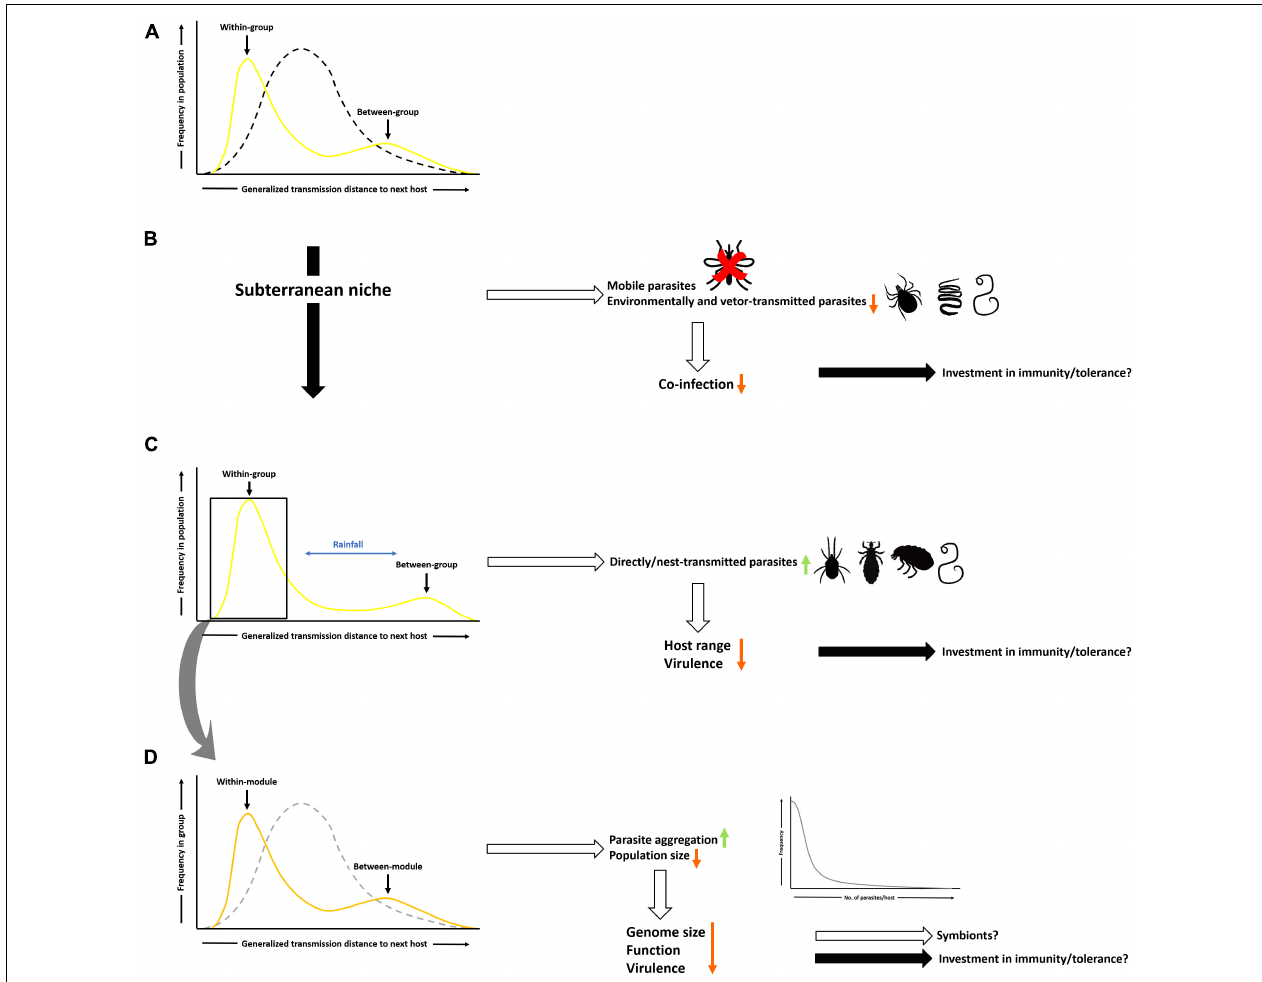
FIGURE 2 | Compositive distance space [i.e., generalized transmission distance (GTD) derived from spatiotemporal, genetic and ecological distance between hosts, a theoretical measure of transmission distance] and its predicted effects on parasite exposure and selection pressures on parasites and bathyergid hosts. This measure incorporates characteristics of the social organization and group size of a particular species. (A) GTD is unimodal for solitary hosts (black, dashed line) but bimodal for social hosts (yellow line) due to short GTDs between group members (within-group) but long GTDs between groups. (B) Living in a subterranean environment excludes mobile parasites and reduces exposure to environmentally-transmitted or vector-borne parasites (e.g., ticks, helminths). For parasites (open arrows) this reduces their degree of co-infection with variable host investment (solid arrows) in physiological defenses (i.e., resistance vs. tolerance). (C) In a subterranean environment GTDs for within and between-group transmission vary with rainfall and soil properties but are generally larger for the latter compared to terrestrial species. These conditions favor directly transmitted parasites (e.g., mites), but pose constraints on their host range and virulence with uncertain consequences for host investment in physiological defenses. (D) Behavioral responses of hosts (i.e., organizational immunity) can further generate differential patterns of GTDs depending on their presence (orange line) or absence (gray, dotted line). The former causes further parasite aggregation (curve on the bottom right) and reductions in population size. For parasites this can result in reductions in genome size and associated function as well as further decreases of virulence and potentially evolution of symbiotic relationships with unknown consequences for physiological defenses employed by